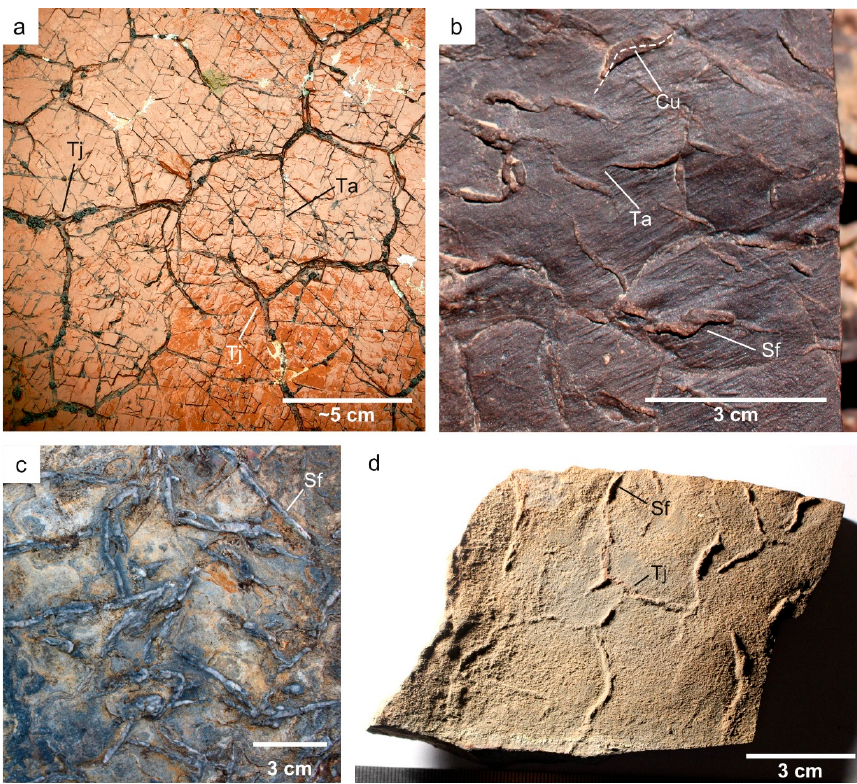
Figure 3. Sedimentary cracks and their salient features. ( a ) Mud cracks showing tapering (Ta) and T-junctions (Tj). Gorges de Daluis, France (Permian). ( b ) Shrinkage cracks with curved shape (Cu), tapered edges (Ta) and steep flanks (Sf). Kalshaneh section, Tabas, Central Iran (Lalun Fm., Lower Cambrian). ( c ) Shrinkage cracks with steep flanks (Sf). Vale da Mua section, Portugal (Armorican Quartzite Formation, Lower Ordovician). ( d ) Shrinkage cracks with steep flanks (Sf) and T-junctions (Tj). Penha Garcia Ichnological Park, Portugal (Lower-to-Middle